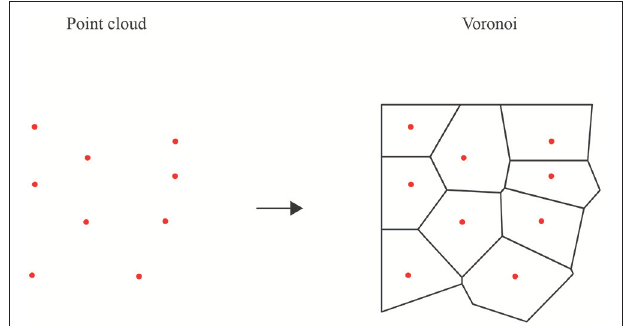
FIGURE 7 | The modified massing volume and its seamless orthograde/contragrade